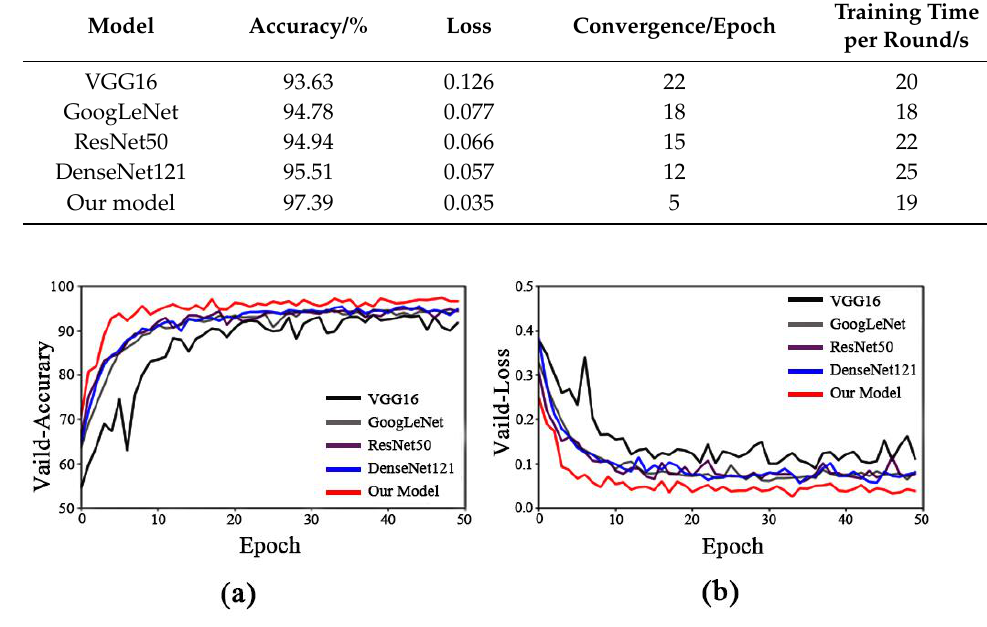
Figure 7. Identification results of each mode. ( a ) Model accuracy; ( b ) model loss.